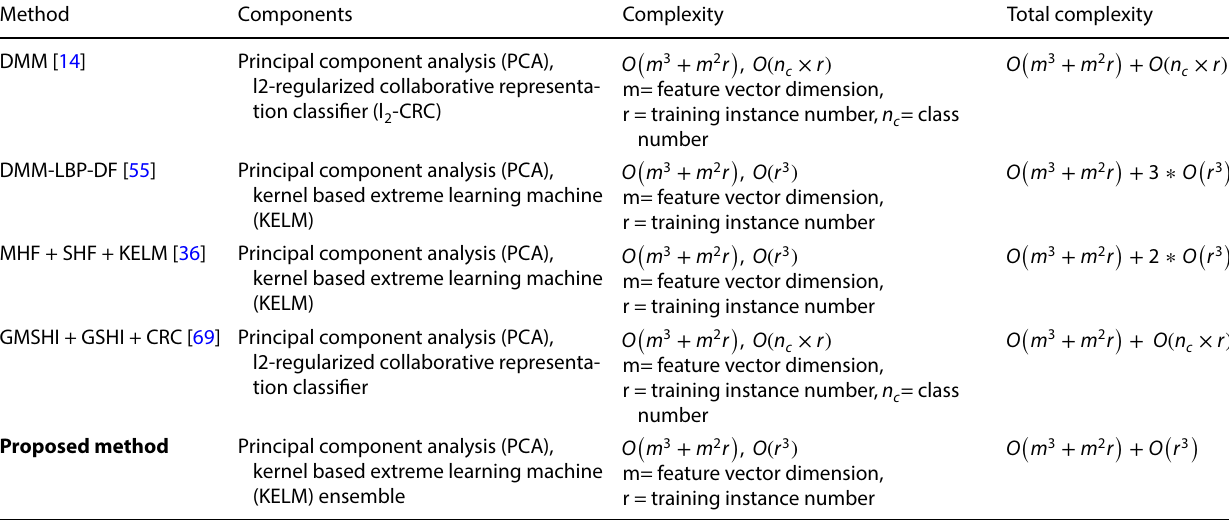
Table 8 Computational complexity comparison of the proposed approach with other existing approaches